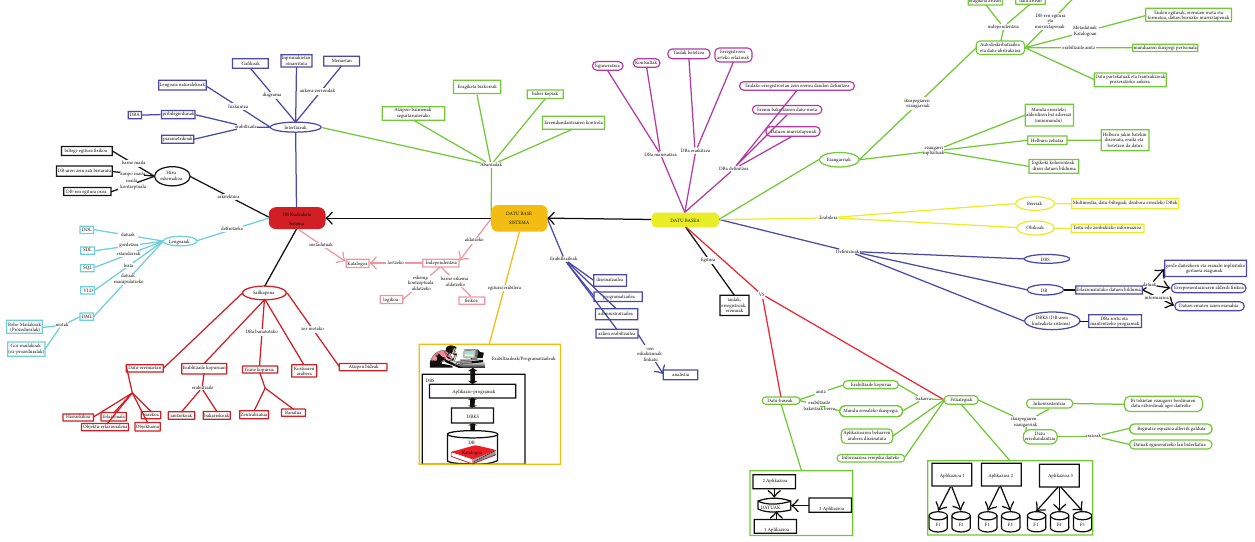
Figure 3: Concept map that prioritizes the visual